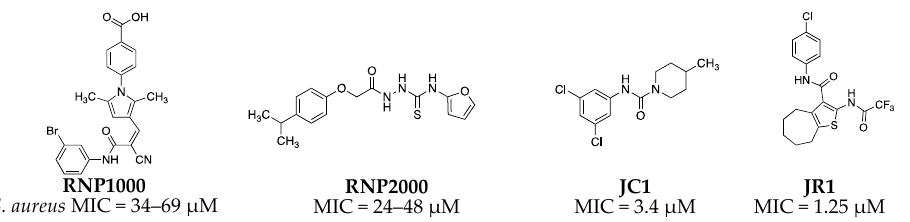
Figure 1. Previously reported RnpA inhibitors with antimicrobial activity against S. aureus .